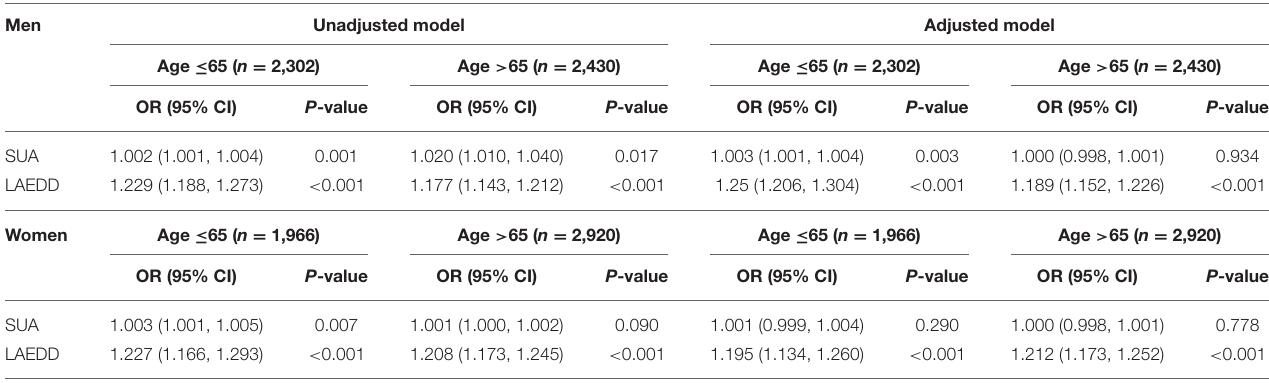
TABLE 2 | The relationship between SUA/LAD and Atrial fibrillation.